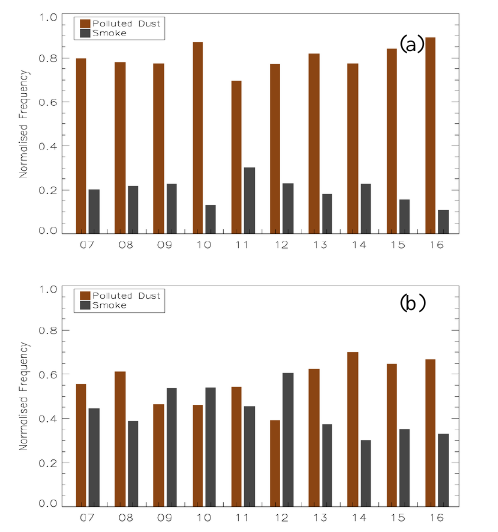
Figure 3 variations in the ratio of polluted dust and smoke over